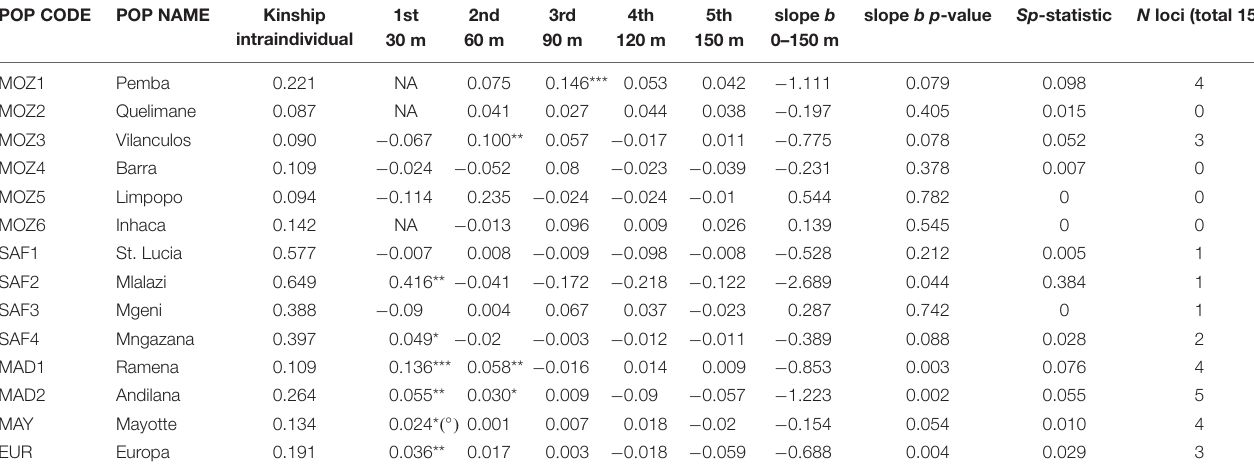
TABLE 4 | Kinship values for five distance classes and linear slope b over 0–150 m for 14 Avicennia marina populations in the Western Indian Ocean region (*** p < 0.001; ** p < 0.01; * p < 0.05); Sp- statistic as an informative parameter for survival strategy; ( ◦ ) F IJ of Mayotte within 15 m; NA, not applicable because of the too low proportion of individuals represented in the interval; N loci, the number of single loci out of 15 that showed significant higher kinship values for at least one of the distance